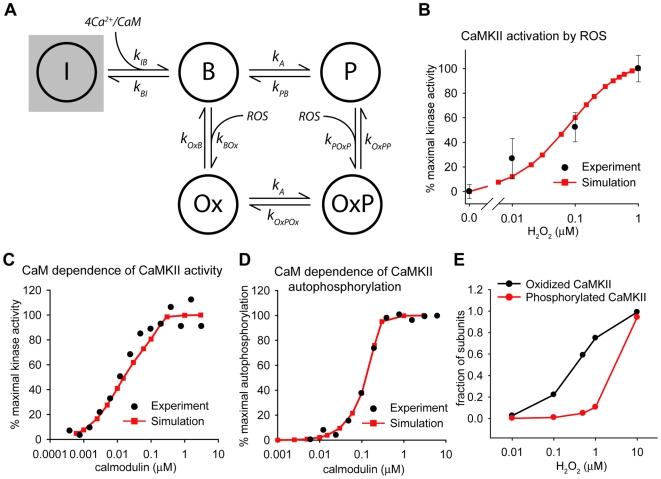
Mathematical model of CaMKII activity.(A) State diagram for CaMKII including activation by Ca2+/CaM (B), oxidation (Ox), and autophosphorylation (P). Rate constants are provided in supplementary information (Text S1 and Table S3). (B) Simulated dose-dependent activation of CaMKII by H2O2 compared to experiment [12]. Ca2+/CaM  = 1 µM and autophosphorylation rate  = 0 in simulations corresponding to the following experimental conditions: 200 µM Ca2+, 1 µM CaM in the absence of ATP (to prevent autophosphorylation). Simulated CaM dependence of (C) CaMKII activity and (D) autophosphorylation compared to experiment [50]. Saturating conditions for Ca2+ (Ca2+ = 0.5 mM) are used in experiment and simulation to allow for control of [Ca2+/CaM] by varying [CaM]. (E) Simulated levels of CaMKII oxidation and autophosphorylation in the BZ model for different levels of oxidative stress (model paced to steady-state at cycle length of 500 ms).